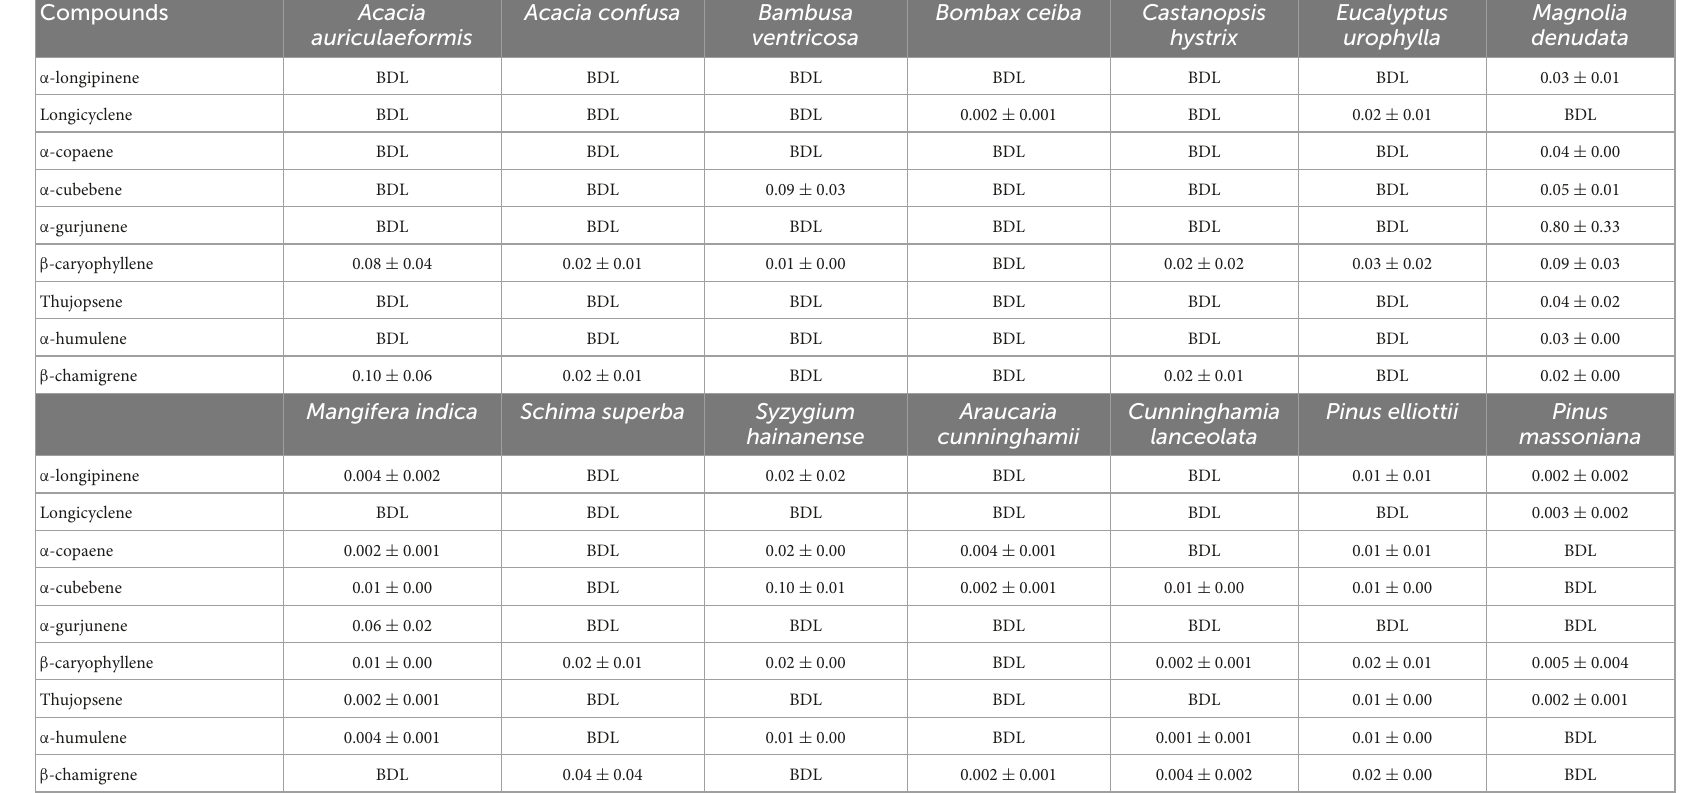
TABLE 4 Emission factors ( µ g g − 1 h − 1 ) of different sesquiterpene (SQT) species emitted from the measured trees.